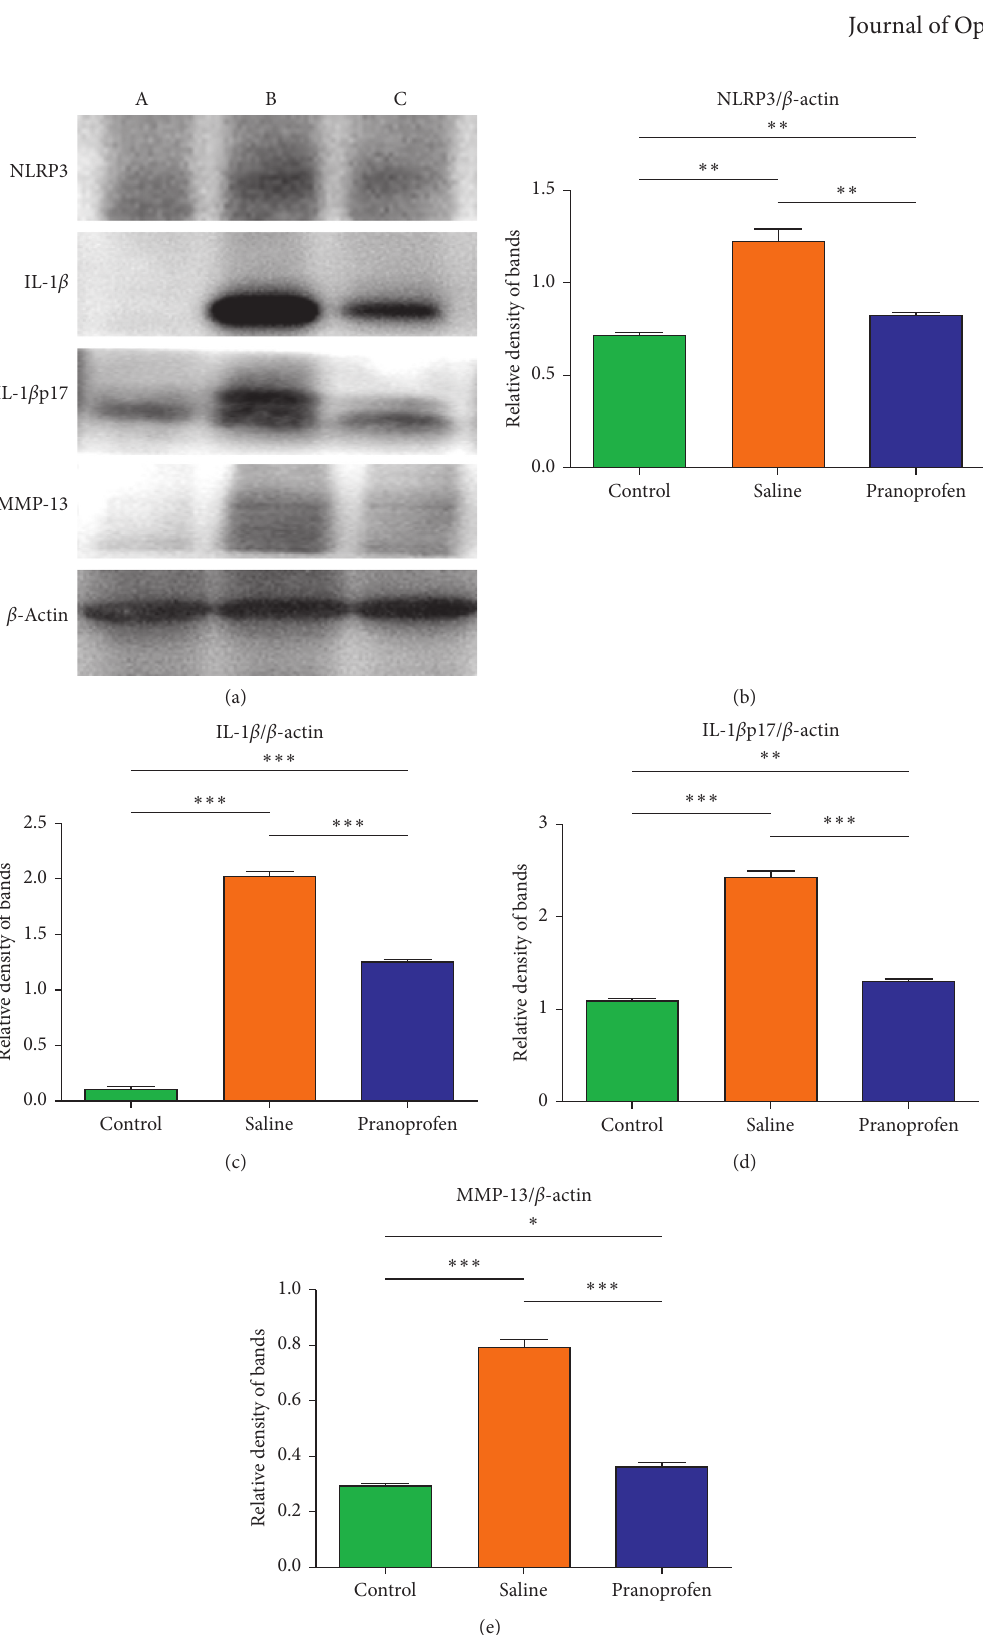
Figure 4: The protein expression of NLRP3, IL-1 β, IL-1 β 17p, and MMP-13 in the control group (A), saline group (B), and pranoprofen group (C) by performing western blot. The proteinic expression of (a) NLRP3, (b) IL-1 β , IL-1 β 17p, and (c) MMP-13 in the control group (0.72 ± 0.024, 0.11 ± 0.002, 1.10 ± 0.028, and 0.30 ± 0.008) appeared to be significantly lower than the other two groups. Additionally, the protein expression of NLRP3, IL-1 β , IL-1 β 17p, and MMP-13 of the saline group (1.23 ± 0.066, 2.03 ± 0.043, 2.45 ± 0.05, and 0.80 ± 0.030) were higher than those of the pranoprofen group (0.84 ± 0.008, 1.27 ± 0.022, 1.30 ± 0.020, and 0.36 ± 0.017). Data are shown as mean ± SD; n � 6, ∗ P < 0 . 05, ∗∗ P < 0 . 01, ∗∗∗ P < 0 .